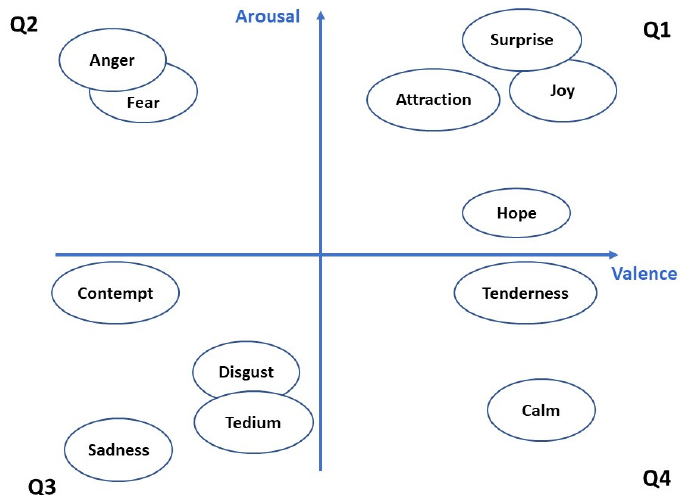
Figure 1. Discrete emotions draft mapping in a 2-dimensional space for arousal and valence.